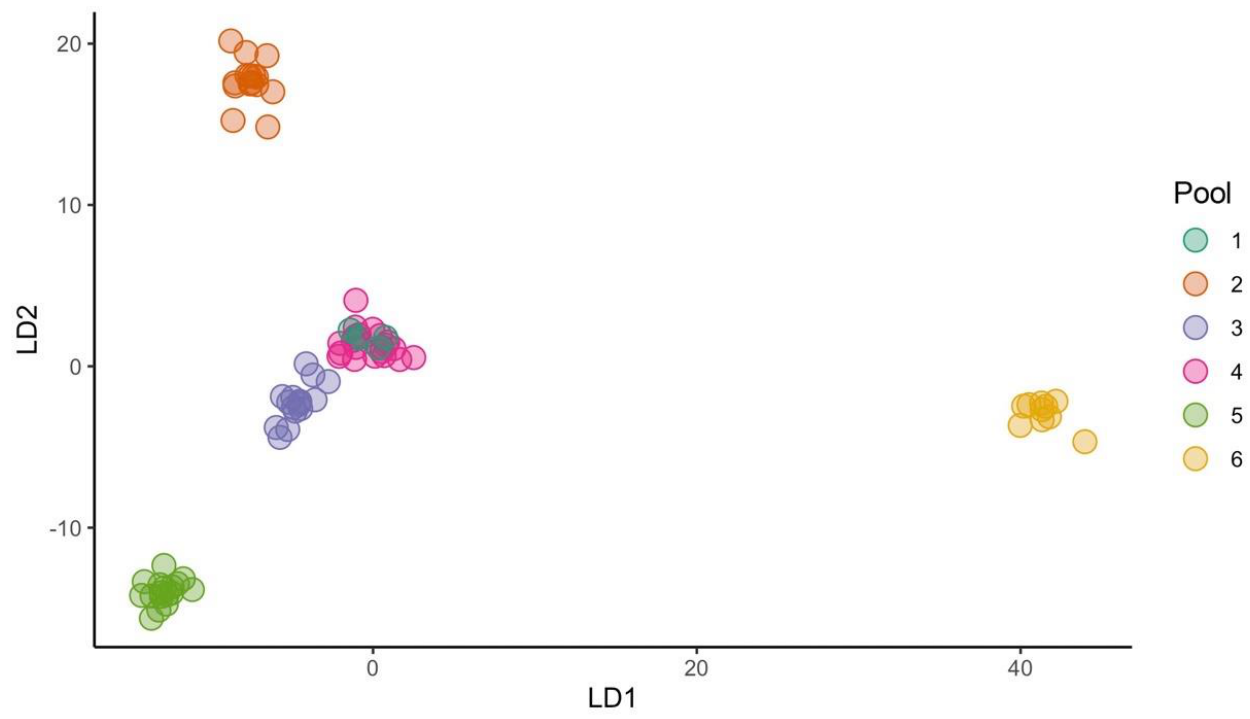
Figure 4. DAPC scatter plot of the 84 accessions belonging to T. turgidum subsp. durum (Table S1) based on the first and second linear discriminants (LDs) at the best K (6) as evaluated using the BIC method (Figure S5A). The membership for each sample is highlighted in Figure S5B.